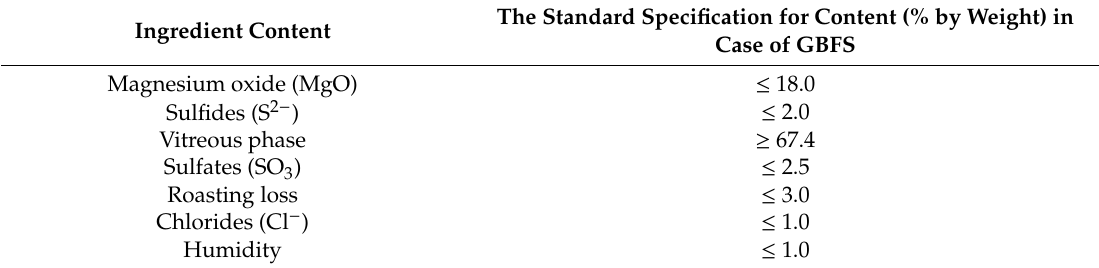
Table 8. The chemical requirements to be met by the slag GBFS and in comparison the research results of MSWI.